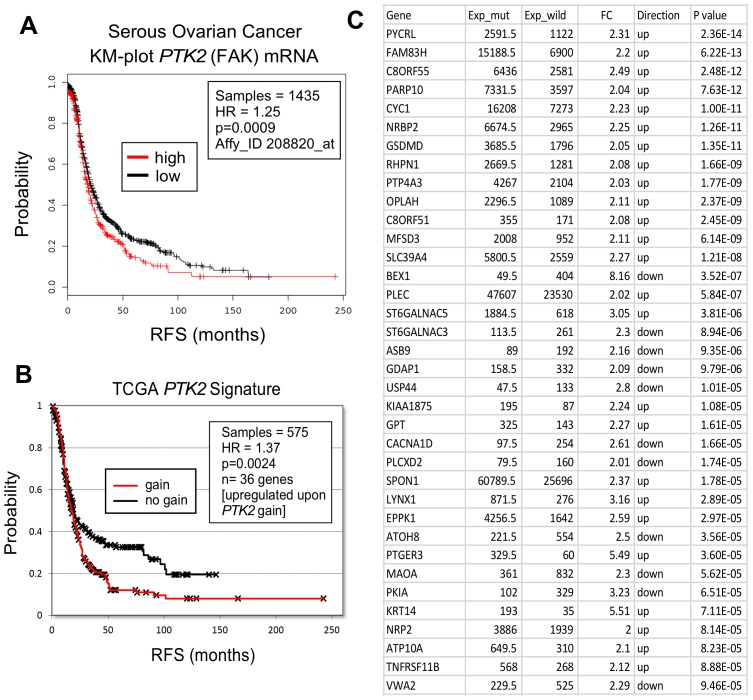
Elevated PTK2 mRNA is associated with a poor prognosis in ovarian cancer.(A) Kaplan-Meier (KM) analysis of PTK2 mRNA (FAK) levels in 1435 patient samples. Plot shows probability of relapse-free survival (RFS) in months with tumors high (red) or low (black) for PTK2 mRNA (HR = 1.25, p=0.0009). (B) KM plot of PTK2 signature (red, Panel C) versus no gain (black) showing RFS (HR = 1.37, p=0.0024). (C) List of 36 genes (p<9.45E-05) that show copy number fold-change (FC) at least = 2 in HGSOC tumors with PTK2 gains. Direction: up is gain and down is loss.